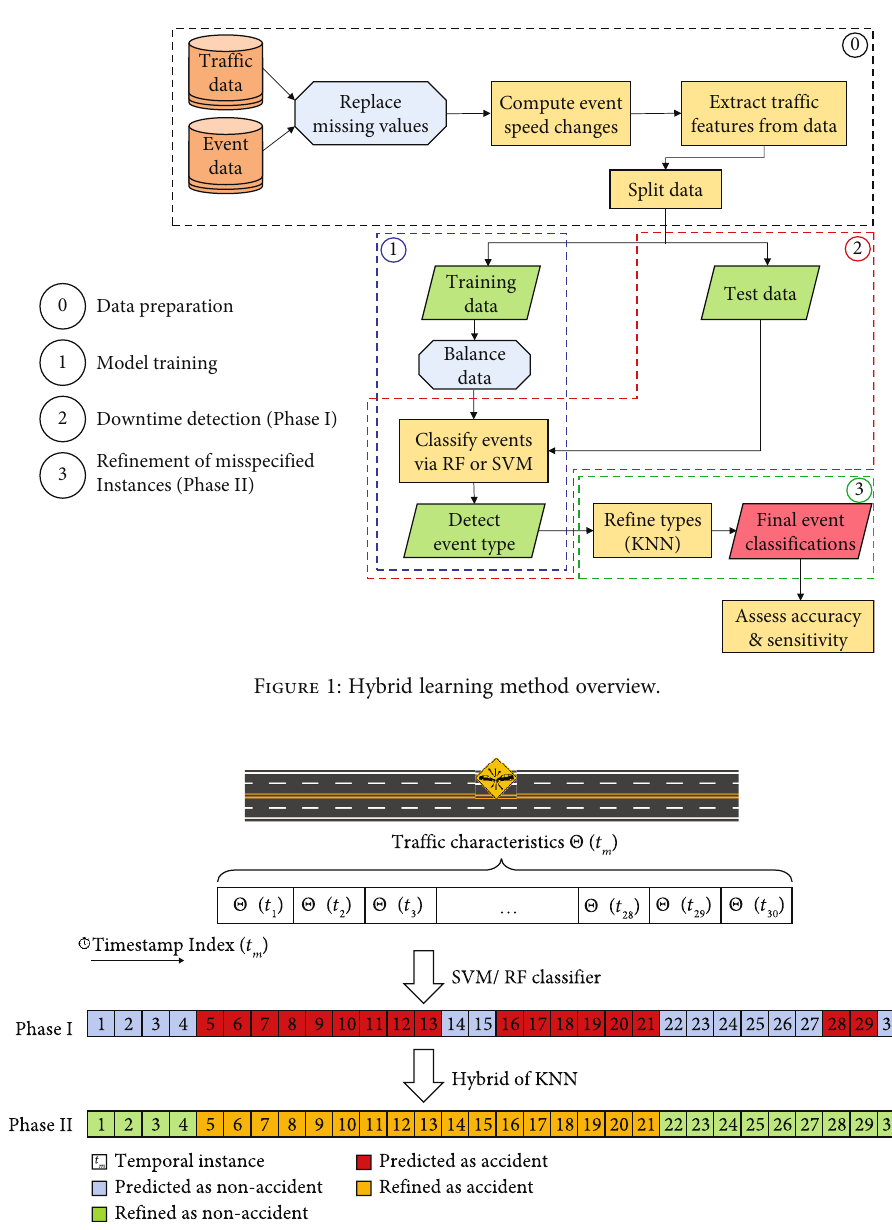
Figure 2: Illustrative example of the proposed hybrid